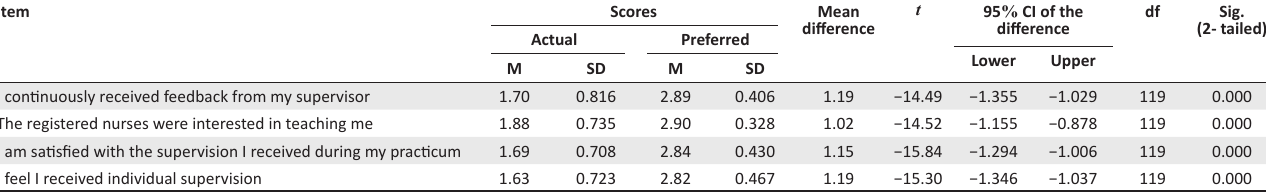
TABLE 3: Mean score differences between the actual and preferred versions for support and supervision scale.